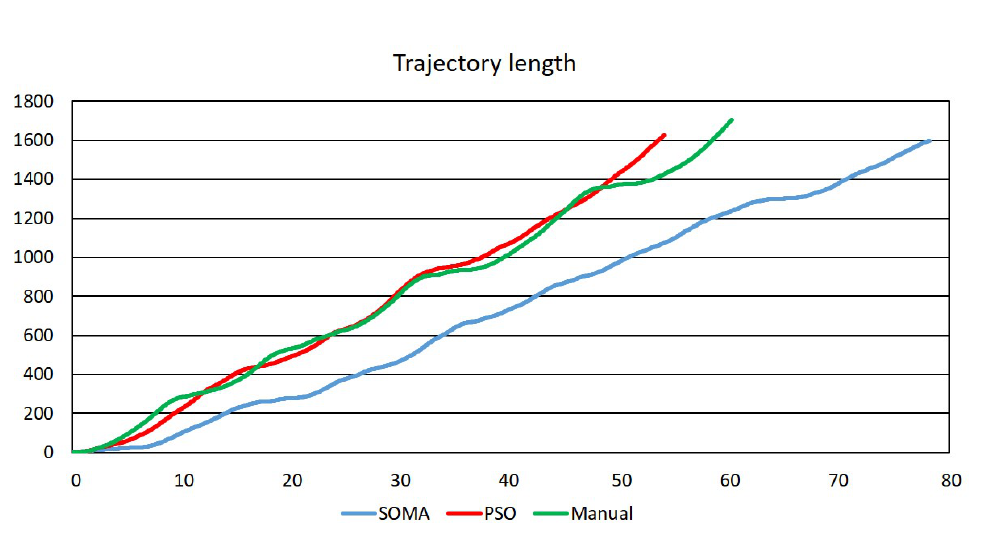
Figure 12. Comparison of trajectory lengths for FCMs designed with help of Particle Swarm Opti- mization (PSO), Self-Organizing Migration Algorithm (SOMA), and manual